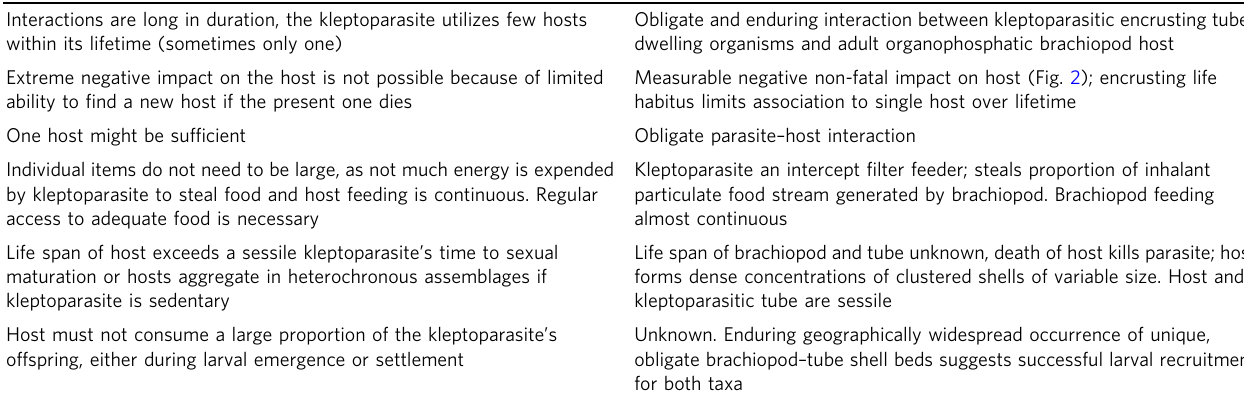
Diagnosis: Adult shell subcircular, no visible pits or pustules on surface, peripherally ornamented with distinct growth lines; metamorphic shell, average of 2396 in width and 1907 μ m in length ( n = 13); ventral pseudointerarea orthocline to apsacline with wide and triangular pedicle groove; ventral propareas vestigial or indistinguishable; dorsal pseudointerarea forming narrow, crescent-shaped rim; ventral visceral fi eld short, slightly thickened and not extending beyond midvalve; dorsal interior with long median septum extending to or beyond 1/3 valve length. Short spirolophe lophophore present (Fig. 3a, b and Supplementary Fig. 4f – h). Marginal chaetae long and closely packed, extending up to 4.6 mm beyond the valve margin, forming a distinctive chaetal fringe (Supplementary Fig. 4a, c – e); Ventral mantle canals baculate (Fig. 1d).